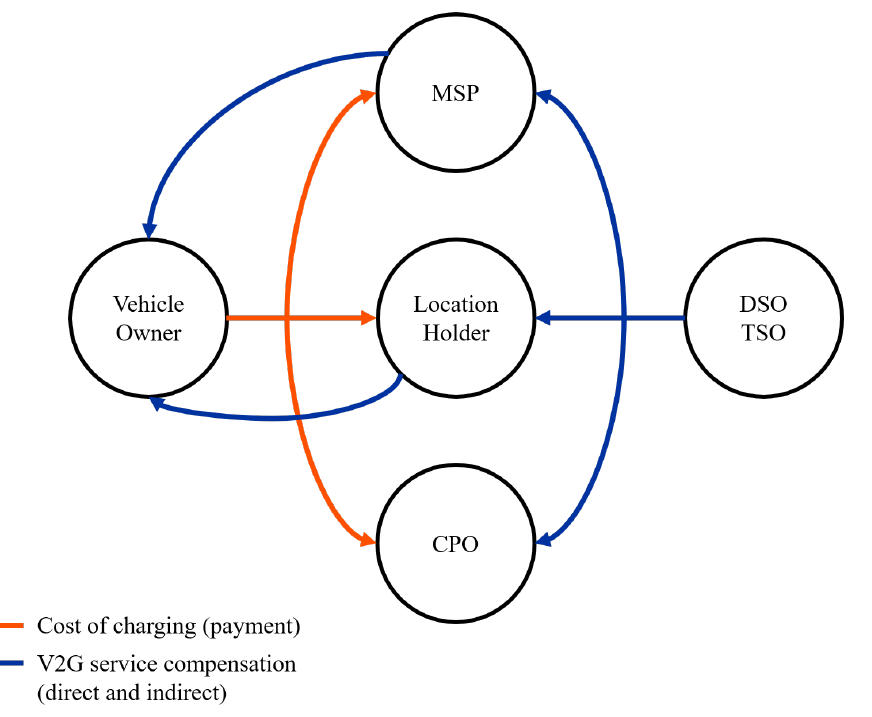
Figure 3. Definition of a public charging case (following [25], own compilation).